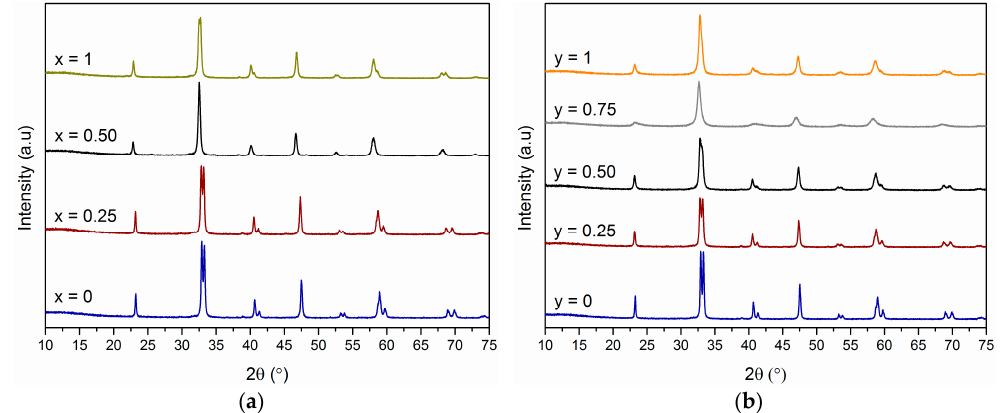
Figure 1. XRD patterns of: ( a ) LaCo 1 – x Mn x O 3 ; ( b ) LaCo 1 – y Ni y O 3 perovskites.